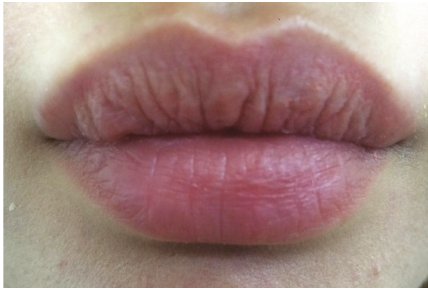
Figure 1: Anterior view of patient on